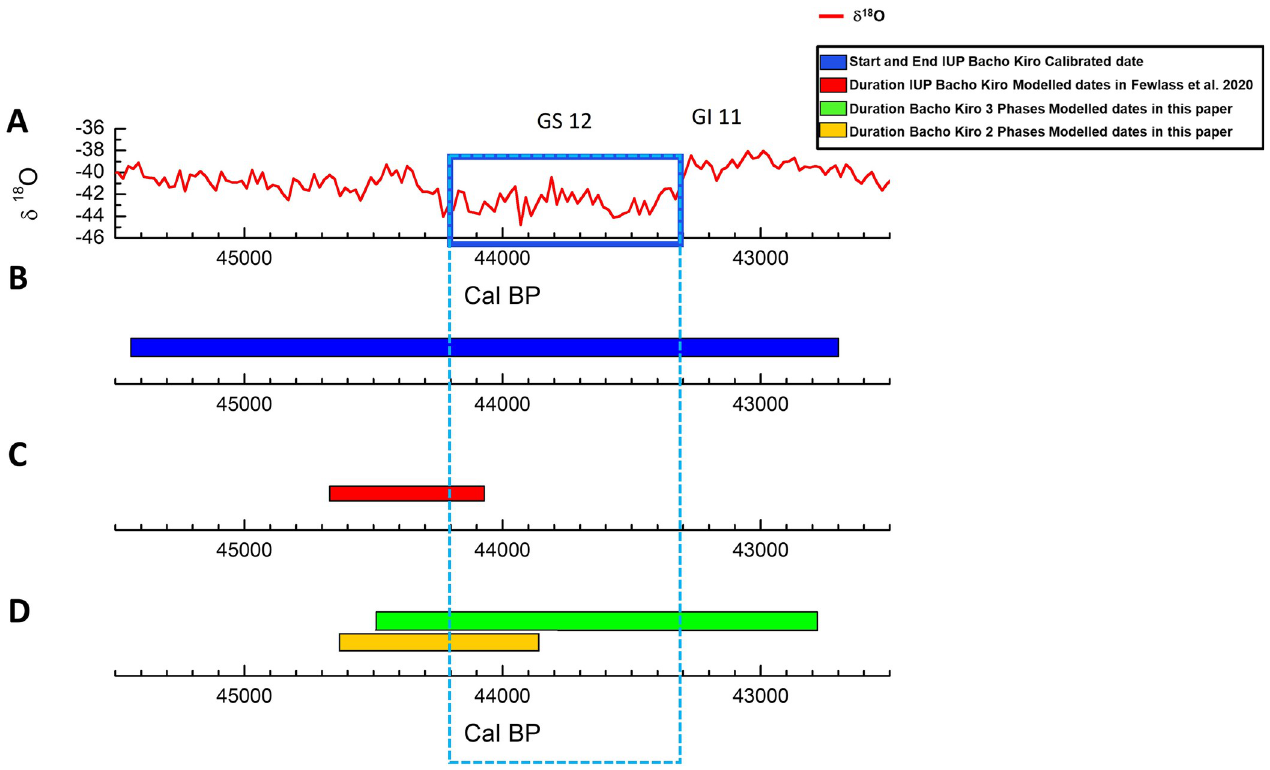
Fig 3. Unmodelled vs Modelled IUP boundaries of Bacho Kiro site. A) the NGRIP δ 18 O curve spanning 45,500 to 42,500 cal BP. B) the IUP duration obtained by the simple calibration dates of the N1-I layer. C) the IUP duration obtained by the OxCal model in [35] of the N1-I layer. D) the IUP duration obtained by the 3 phases model (green) and 2 phases model (yellow). The blue rectangle highlights the GS12 cold climate phase.